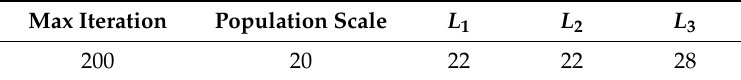
Table 3. Parameters preset in 3-stage GA–SA–SVM.